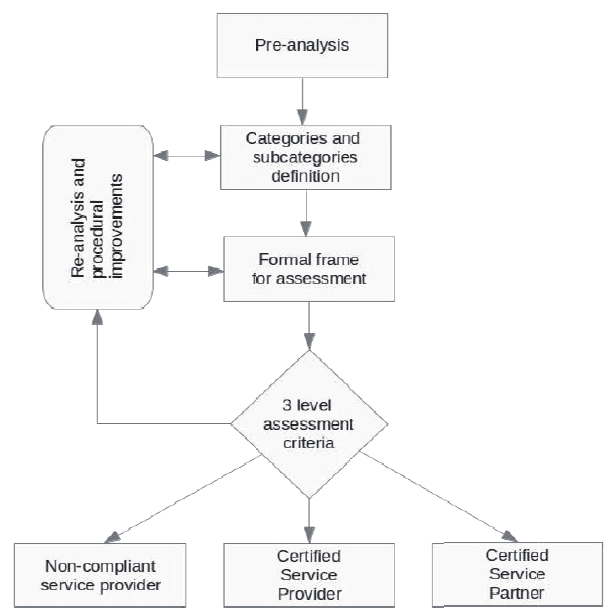
Fig. 4 – Process of assessment tool development. Source: